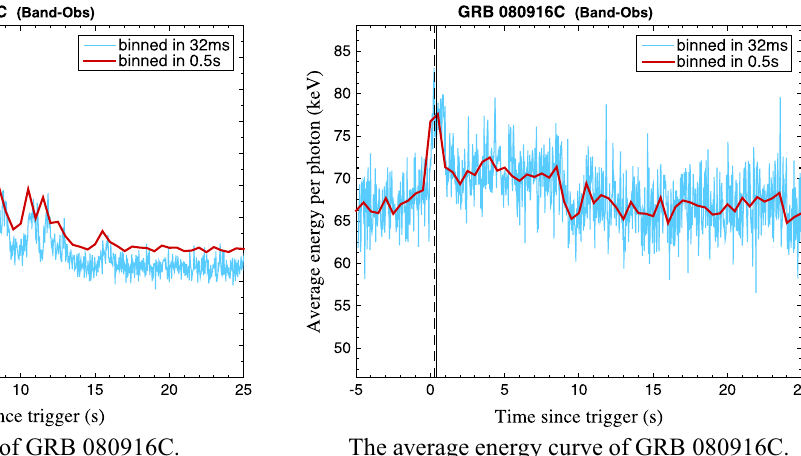
Fig. 7 The light curve and average energy curve of GRB 080916C in Band-Obs. The x -axis refers to Δ t obs /( 1 + z ) . The vertical solid lines refer to t obs /( 1 + z ) chosen by Criterion 0 (the first main peak of the